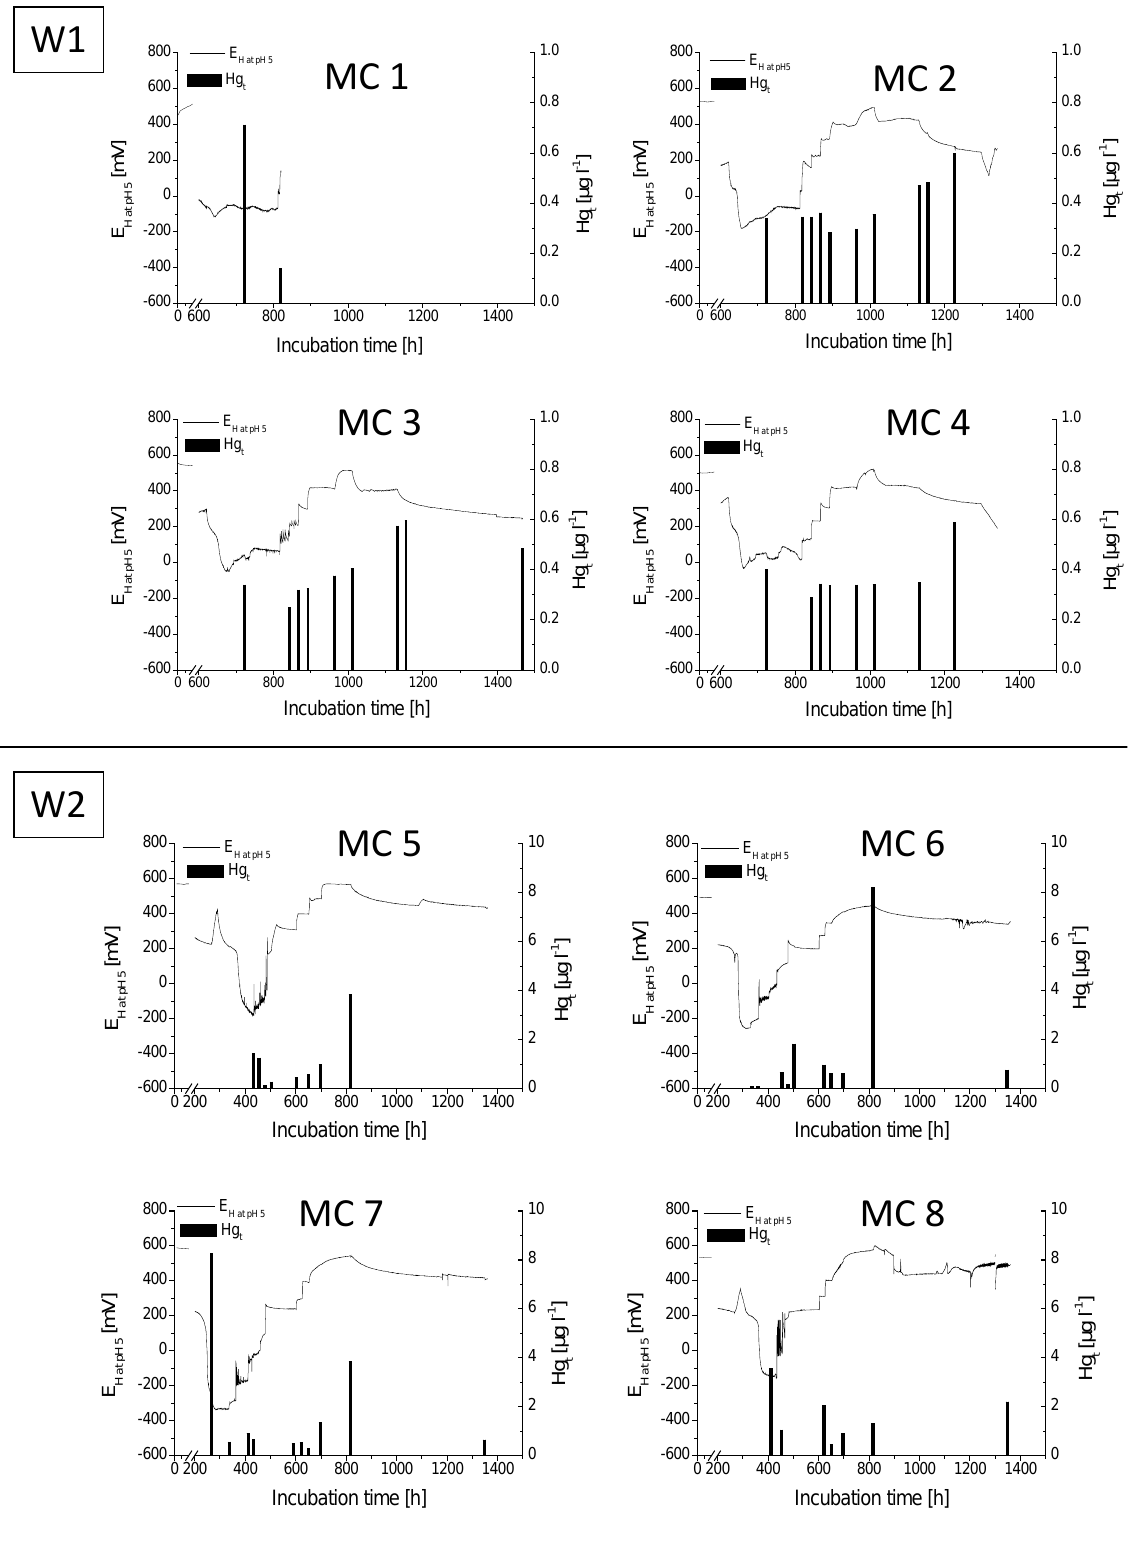
Fig. 4. E HatpH5 measured in the slurry every 10min and Hg t concentrations in the soluble fraction during the experiment for each microcosm (MC) (Wupper 1 = W1, Wupper 2 =